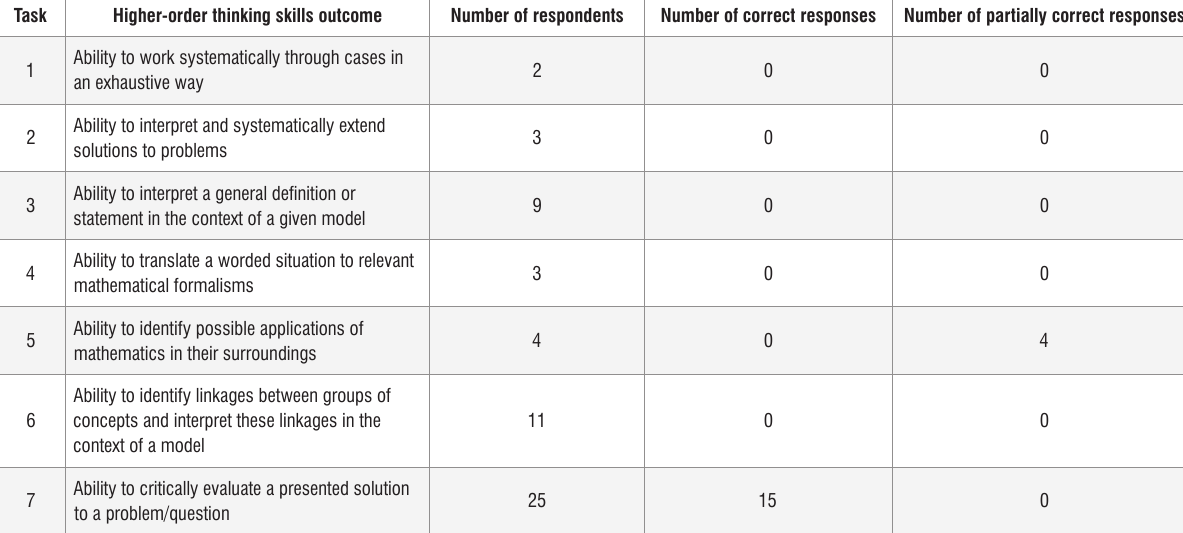
Table 2: Summary of student ( n =48) responses to the seven tasks